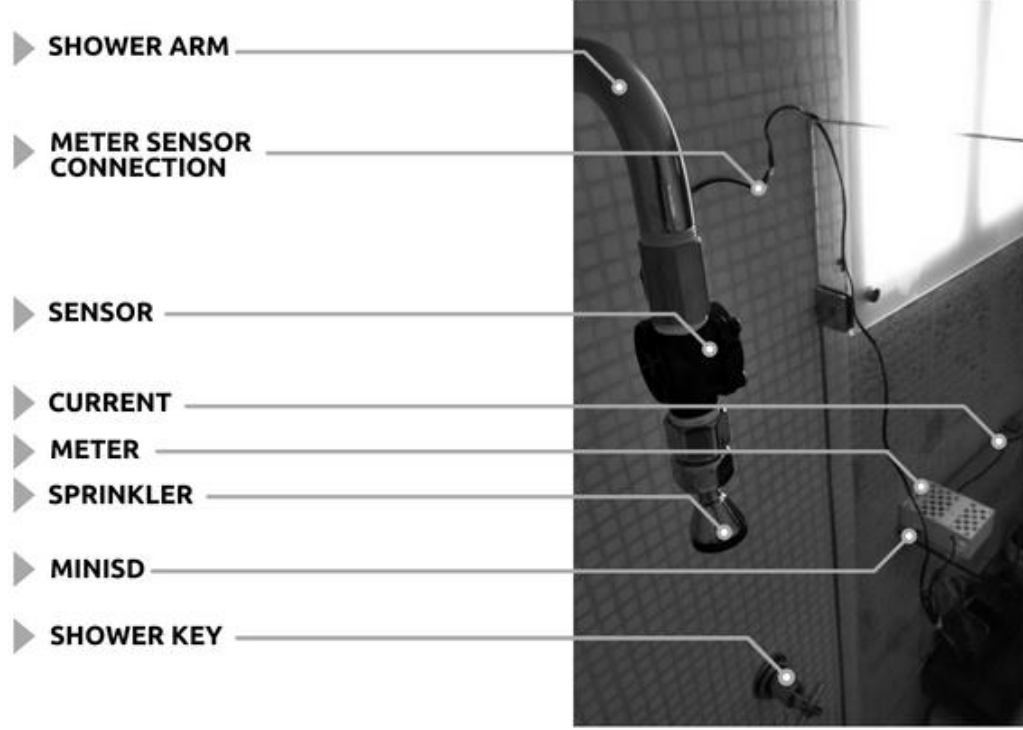
Figure 4. Measurement of water